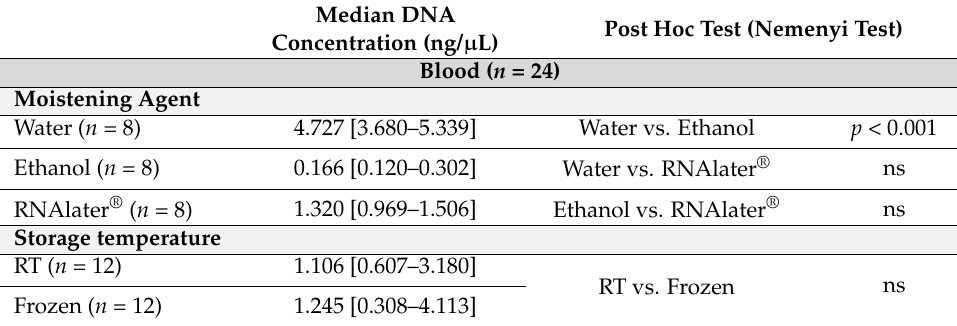
Table 1. Median concentrations of human genomic DNA in experimental samples subdivided by stain type, moistening agent, storage temperature (RT: room temperature), and storage time before processing. The interquartile range (IQR) is given between brackets. p -values of the Nemenyi test are shown in the column to the right (ns denotes